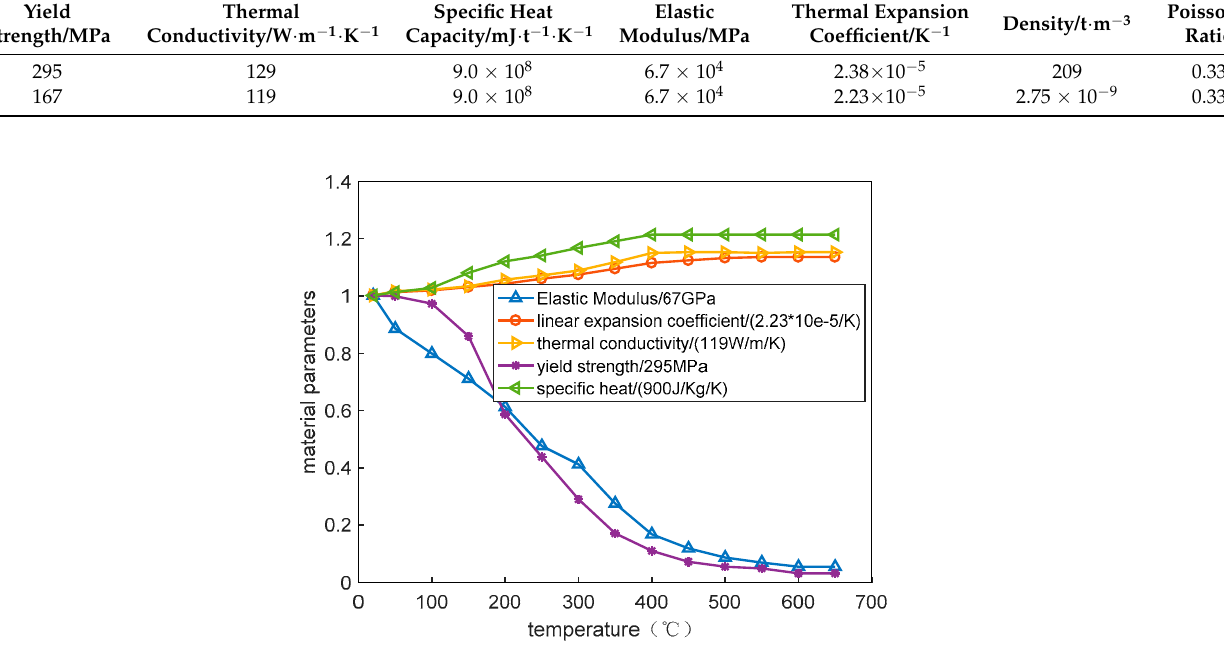
Figure 7. Material parameters of 7005 aluminum alloy as a function of temperature. The manual inert gas tungsten arc welding (GTAW) of the rolled aluminum alloy7005 was conducted, by using a weld filler wire of ER5356 type with a wire diameter of 1.2 mm. Four fillet welds are welded in turn in a clockwise direction, as show in Figure 8a, and the first and second weld pass have been marked; the plane of transverse stress is shown in Figure 8b) where the welding direction is also drawn. The welding process parameters are summarized in [51]. The heat source was set to be isothermal moving at the welding speed of 10 mm/s. Isothermal heat source means that the temperature of all positions of the filler metal is the same, and there is no temperature gradient, which is also the simplest welding heat source. Its temperature is 660 ◦ C which is consistent with the melting point of the material. The distribution of transverse residual stress along the hypothetical crack propagation cross-section is presented in the following sub-section. For welding simulation, the element type is C3D8, and there are 26600 elements in